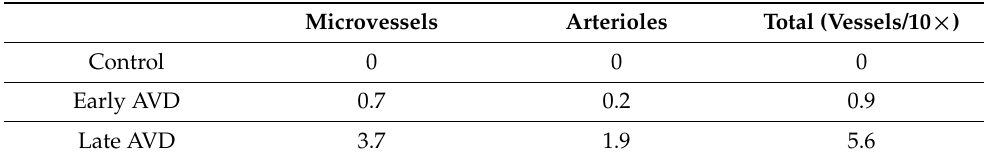
Table 2. CD-31 neovessel quantification and